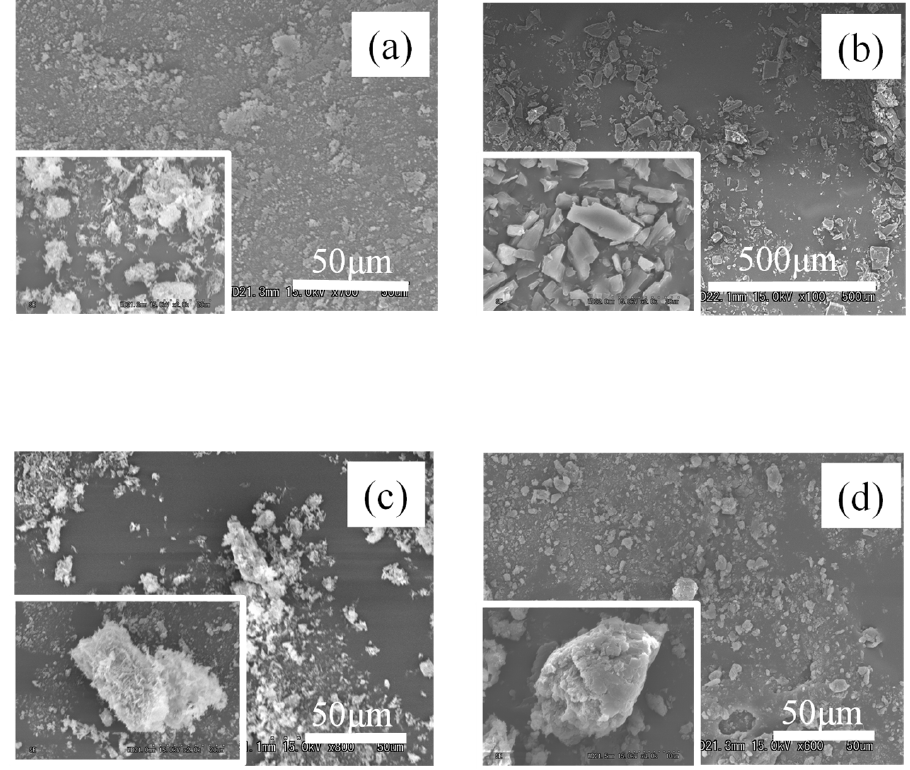
Figure 9. SEM analysis of EA/UR systems. ( a ) EA; ( b ) UR; ( c ) PM (EA/UR = 1/1); ( d ) EVP (EA/UR = 1/1).